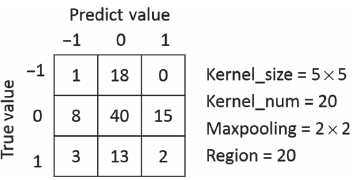
Figure 17: Confusion Matrix of Experiment 3 in Architecture